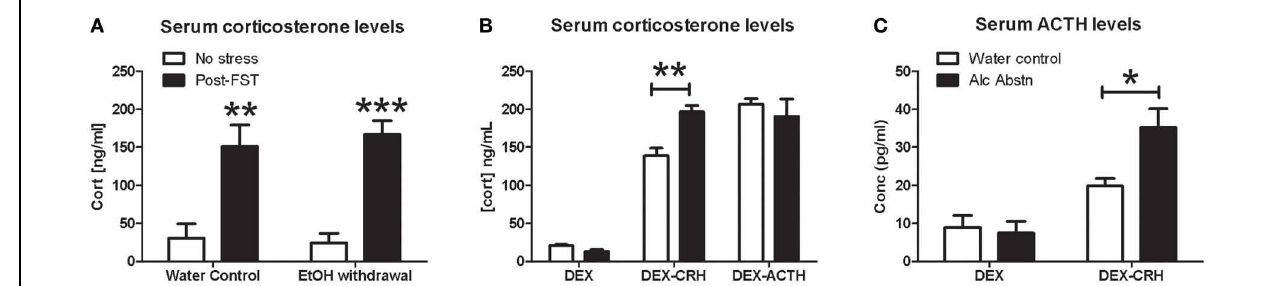
FIGURE 2 | Alcohol abstinence associated with abnormal DEX-CRH response. (A) No significant difference in serum corticosterone levels at baseline and immediately following forced-swim stress. (B) Similar levels of serum corticosterone after DEX and DEX-ACTH challenges. Alcohol abstinent mice had significantly higher corticosterone levels compared to water